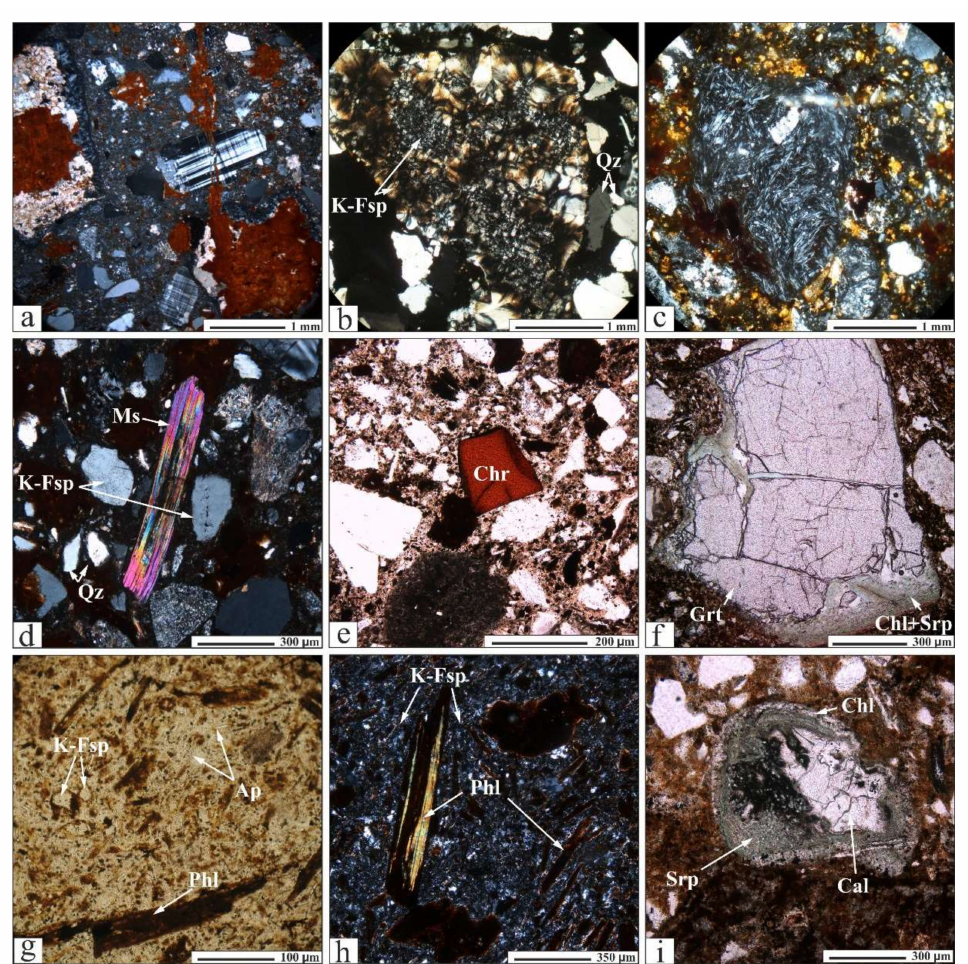
Figure 2. Photomicrographs of medium- to fine-clastic volcanic breccias and a fine-grained matrix Ogonek pipe ( a , d ); autoliths from Gornaya ( b ) and Perevalnaya ( c ) pipes; Cr–spinel ( e ) and garnet ( f ) xenocrysts from Ogonek volcanic breccias; Apatite accessory phase in the matrix of Intrusion 104 rocks’ ( g ); K-feldspar (sanidine) in the cryptocrystalline matrix and phlogopite microphenocrysts replaced by secondary reddish-brownish aggregates of the Intrusion 104 rocks’ ( h ); pseudomorphs after olivine in the Pereval’naya pipe rocks’ ( i ). Abbreviations based on